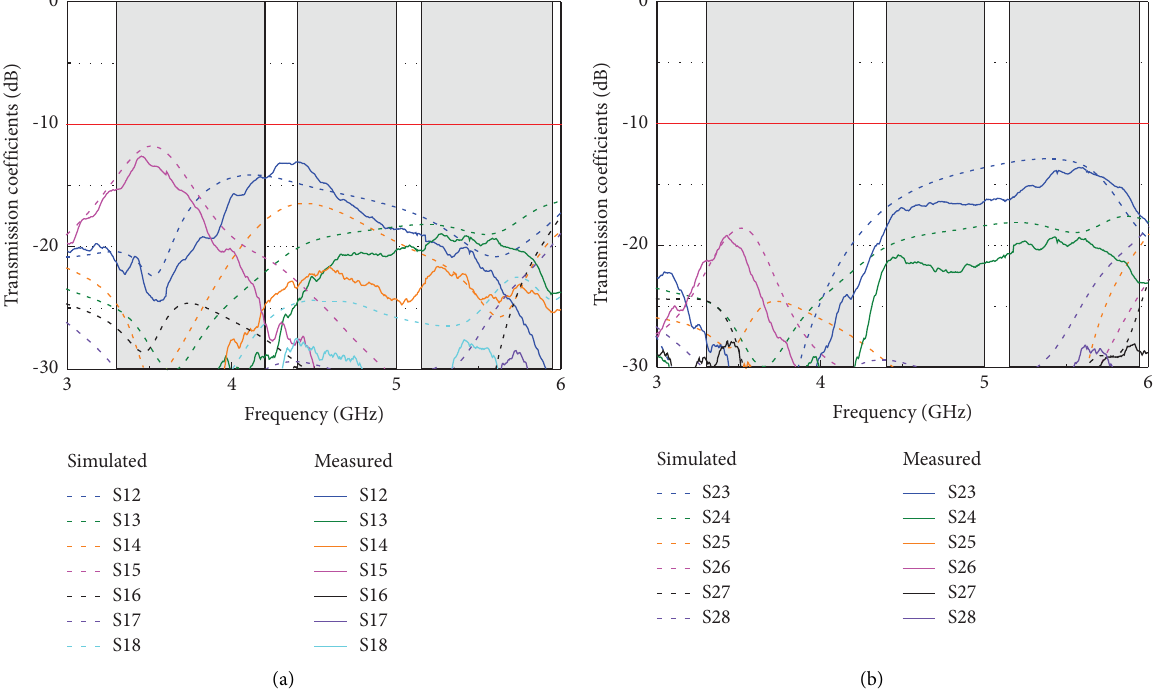
Figure 8: Simulated and measured transmission coefcients (a) between antenna 1 and the other antennas and (b) between antenna 2 and the other